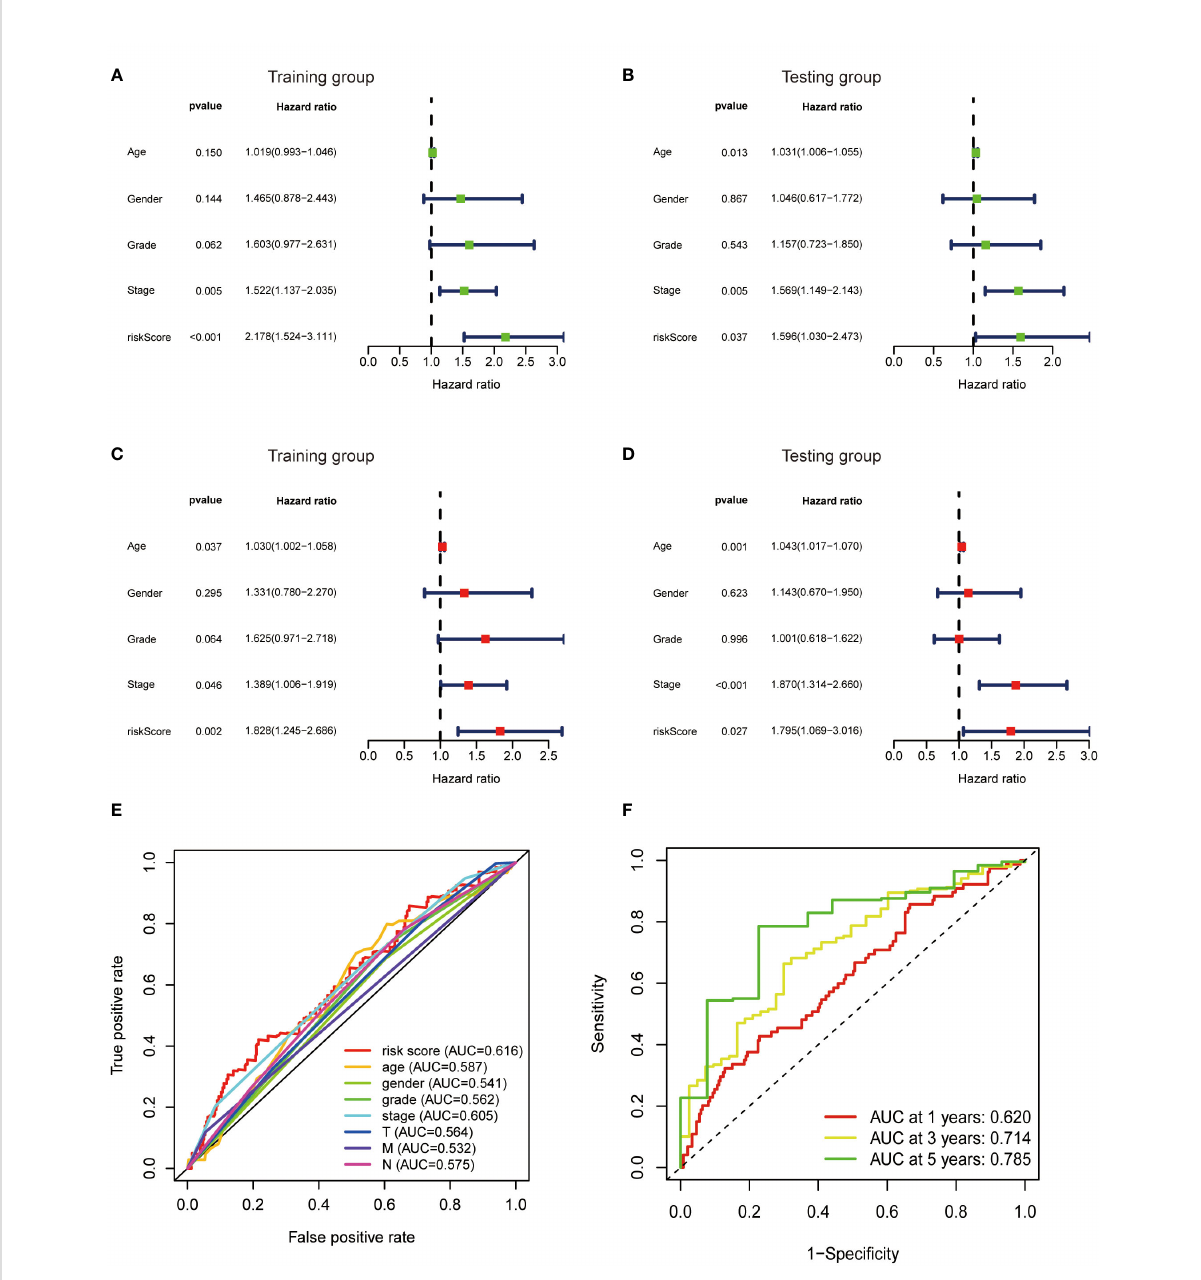
FIGURE 6 Metabolic lncRNAs risk score model was an independent prognostic factor. Univariate (A, B) and multivariate (C, D) Cox regression analysis of the association between clinicopathological features (including risk score) and OS of patients in the training and testing group. (E) The ROC curves of the risk score model and clinicopathological parameters (F) The ROC curves of the risk score model at